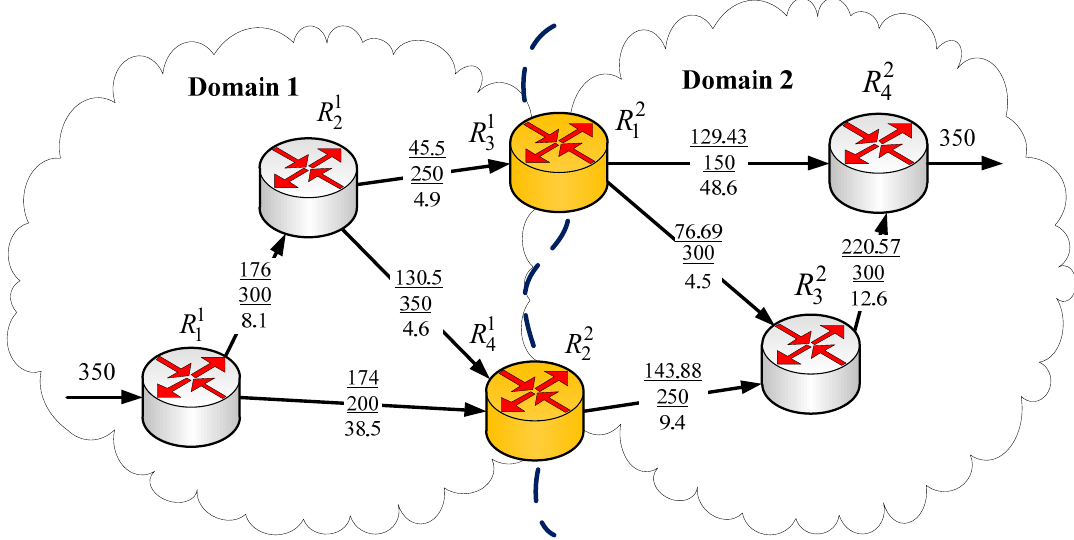
Figure 5. Initial solution to the inter-domain QoS routing problem following the normalized requirements (23). Table 3. Characteristics of the calculated routes in Figure 5. Domain